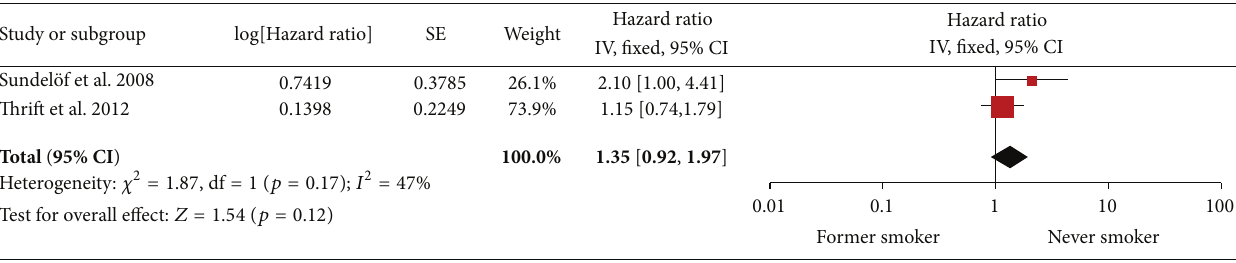
Figure 5: Former versus never smoker.